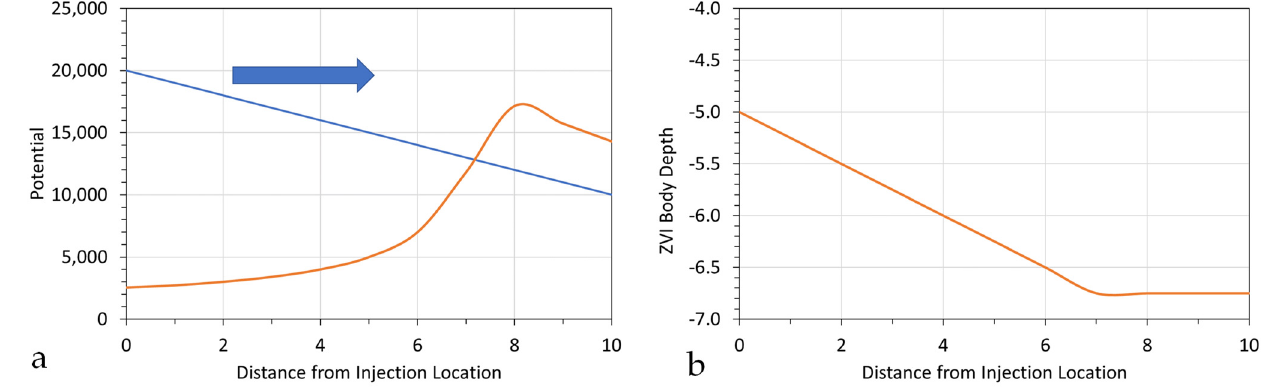
Figure A15. Injected n-Fe 0 hydrodynamic modelling. ( a ), variation in potential with distance from the injection location. Blue line = water; red line = n-Fe 0 ; blue arrow = direction of water flow; ( b ), Depth of the ZVI body within the aquifer as a function of distance from the injection point.